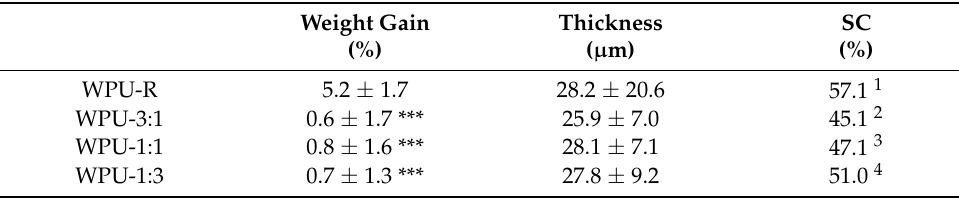
Table 3. Weight of the samples before and after application of the different coating formulations and respective weight gain, solid content (SC) of the pure formulations ( 1 PU-R, 2 PU-3:1, 3 PU-1:1, 4 PU-1:3). Statistical differences are reported as: *** p < 0.001, ** p < 0.01 and * p < 0.05.